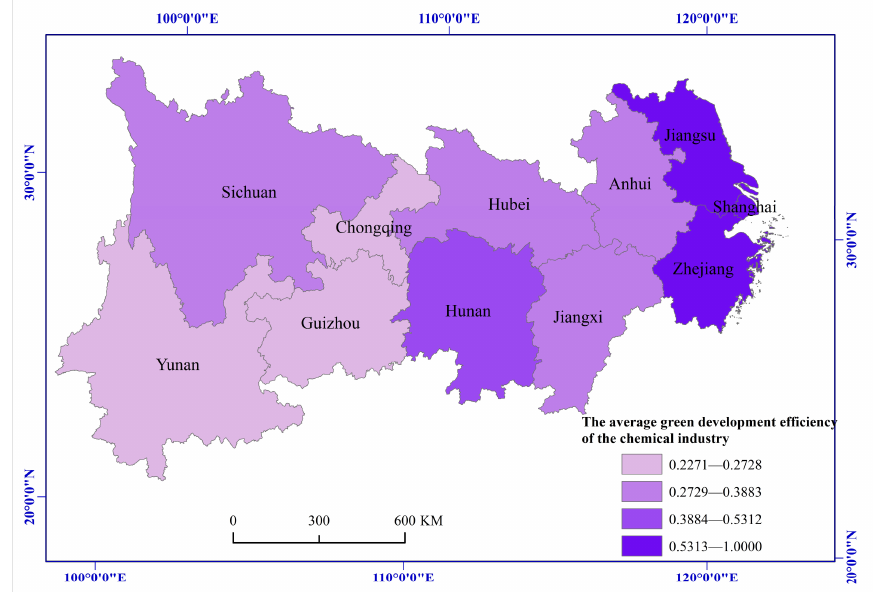
Figure 3. The average green development efficiency of the chemical industry from 2002 to